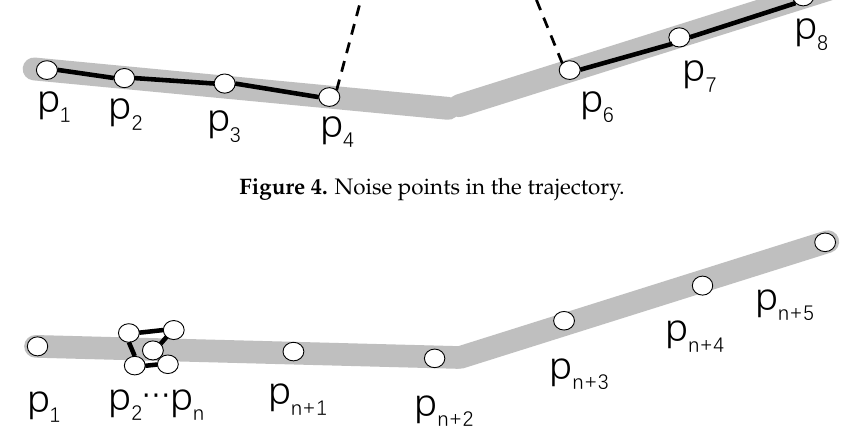
Figure 4. Noise points in the trajectory.